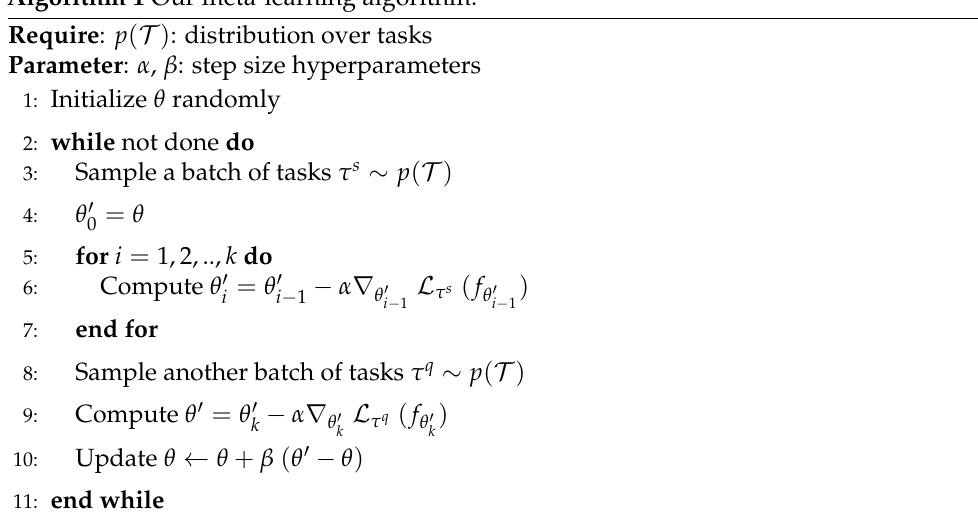
Algorithm 1 Our meta-learning algorithm.